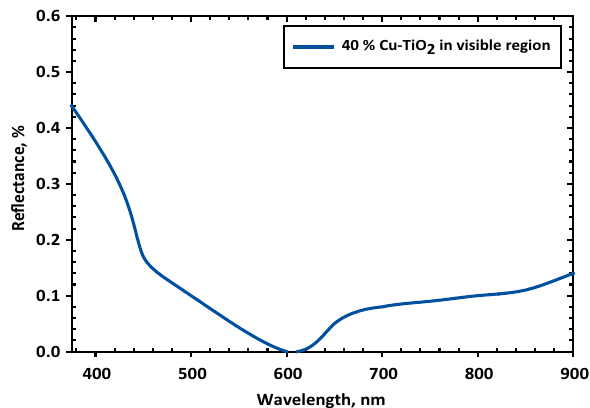
Figure 8. Representative the Cu–TiO 2 as an AR coating for a silicon solar cell.